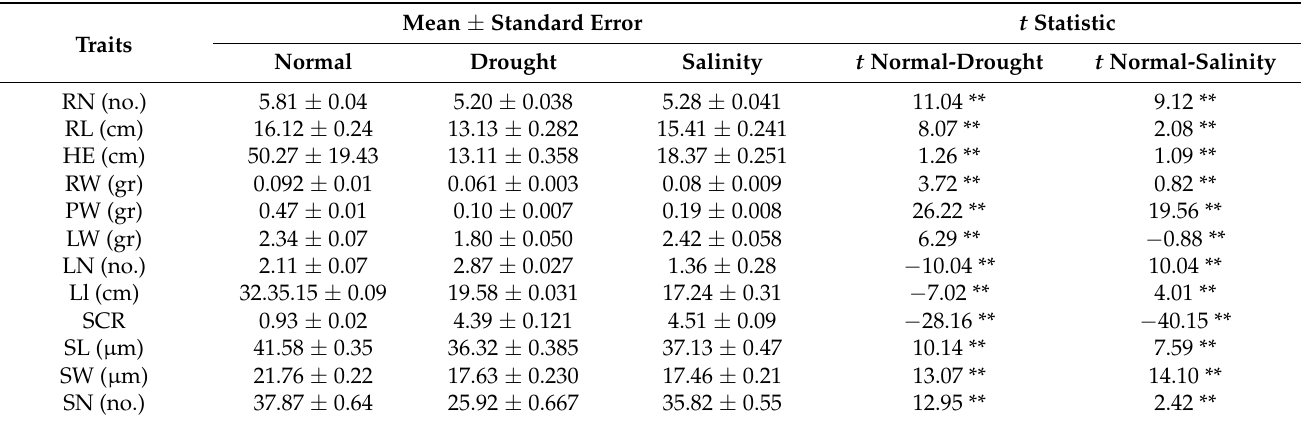
Table 4. Means, standard errors, and t -test between normal and stresses conditions for